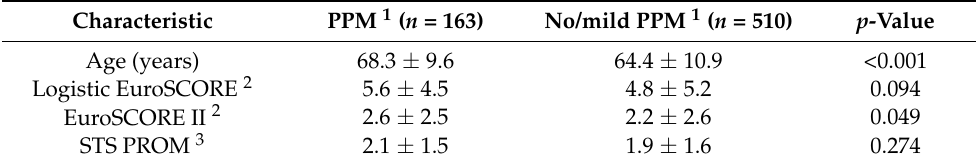
Table 3. Baseline characteristics of the patients with PPM 1 vs. those with no/mild PPM 1 .